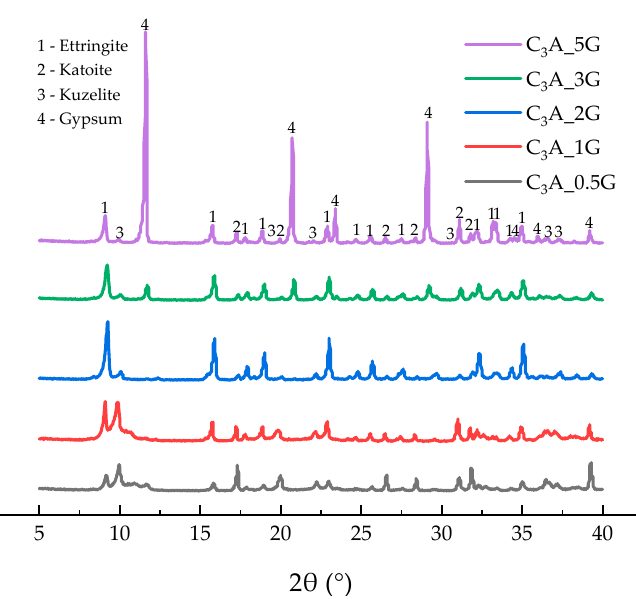
Figure 3. XRD patterns of phases obtained from C 3 A with various amounts of gypsum after the 24-h hydration.